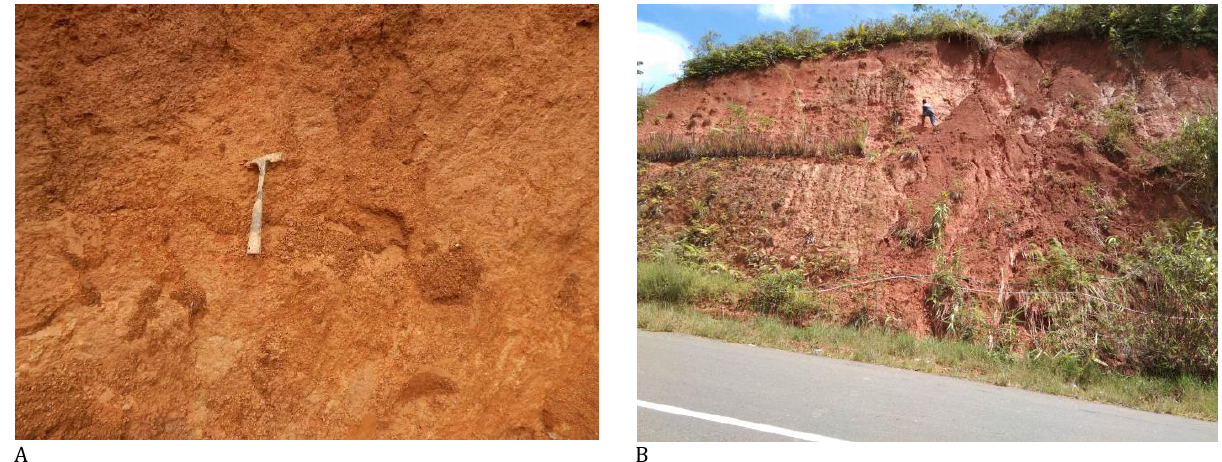
Fig. 2. The soil of the study area (A) and groove erosion (B)